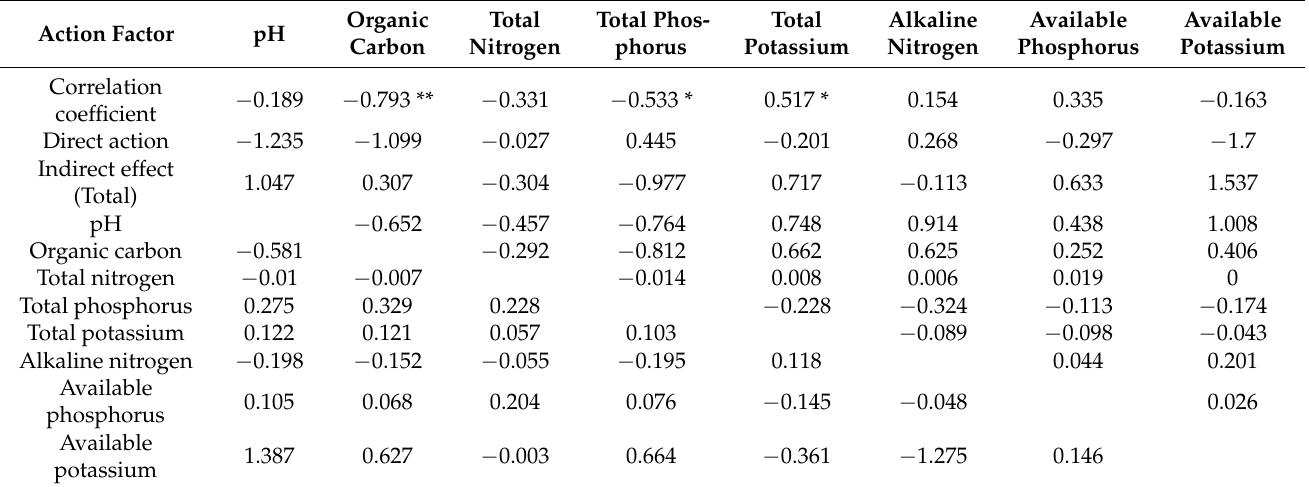
Table 1. Path coefficients of soil physical and chemical properties for the nitrogen content in the new shoots of tea.